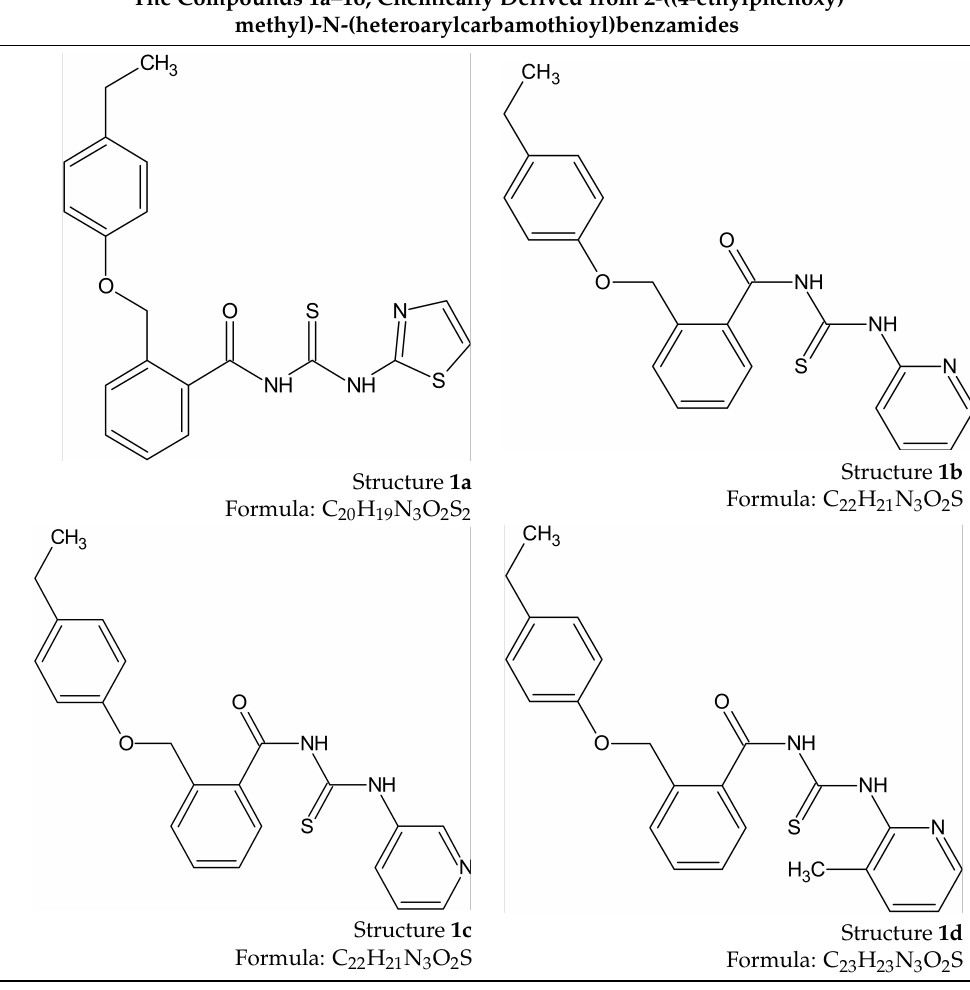
Table 1. The chemical compounds 1a – 1o , considered in the present